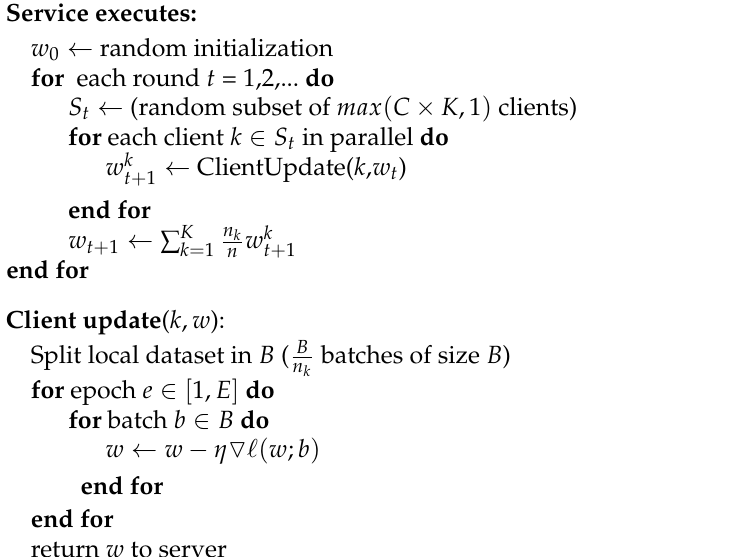
Algorithm 1 FederatedAveraging. The K clients are indexed by k , B is the local minibatch size, E is the number of local epochs, and η is the learning